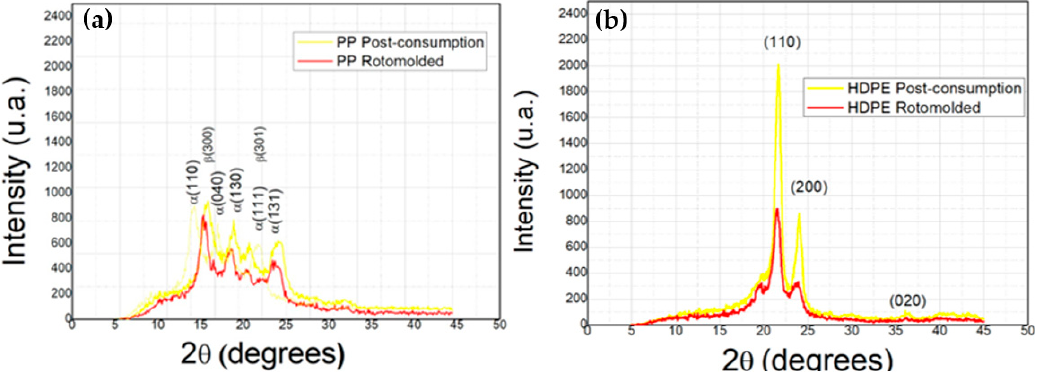
Figure 4. Diffractograms: ( a ) post-consumer and rotomolded PP material; ( b ) post-consumer and rotomolded HDPE material.